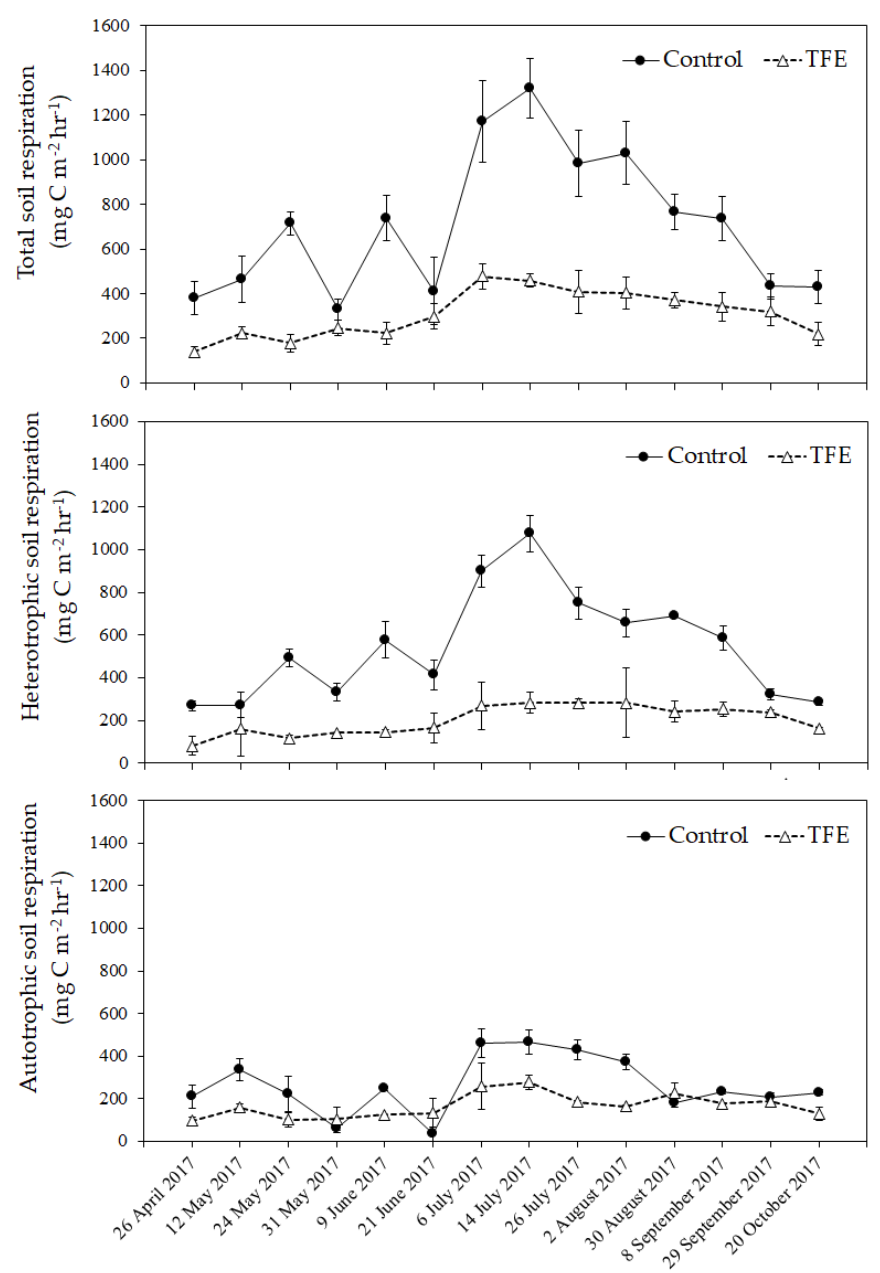
Figure 4. Seasonal variation in soil respiration (soil CO 2 efflux) in control and throughfall exclusion (TFE) plots during the 2017 growing season.